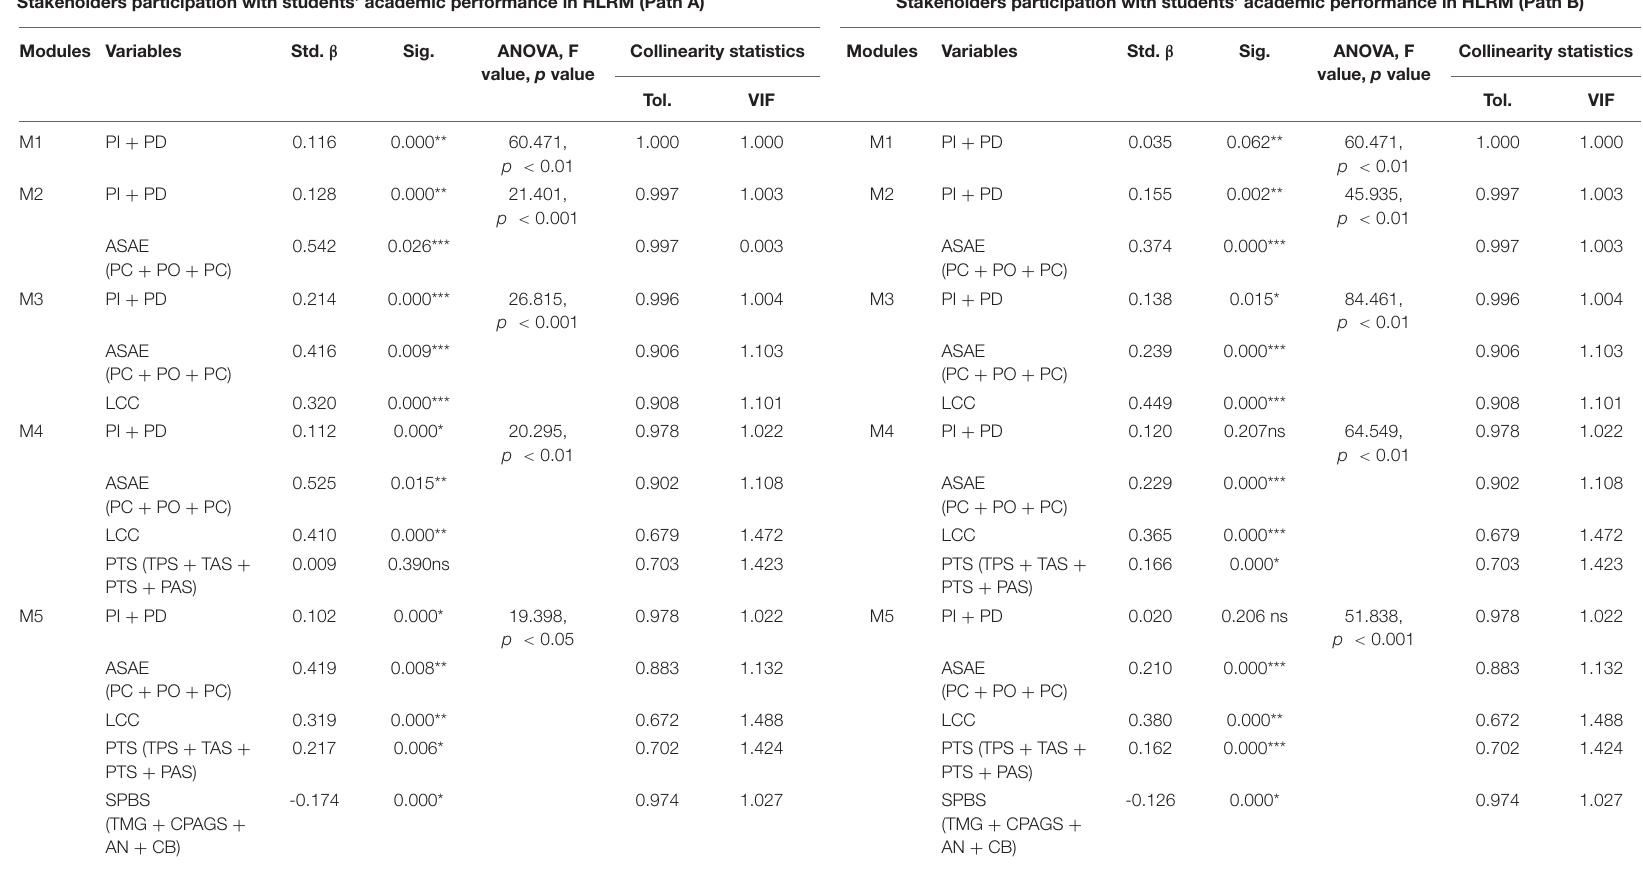
TABLE 7 | Multivariate linear hierarchical regression modeling (HLRM) about stakeholders’ participation (i.e., parents, teachers, peers, and students) along with goal directness and learning climate of the classroom with students’ academic performance through their engagement in high schools ( N =